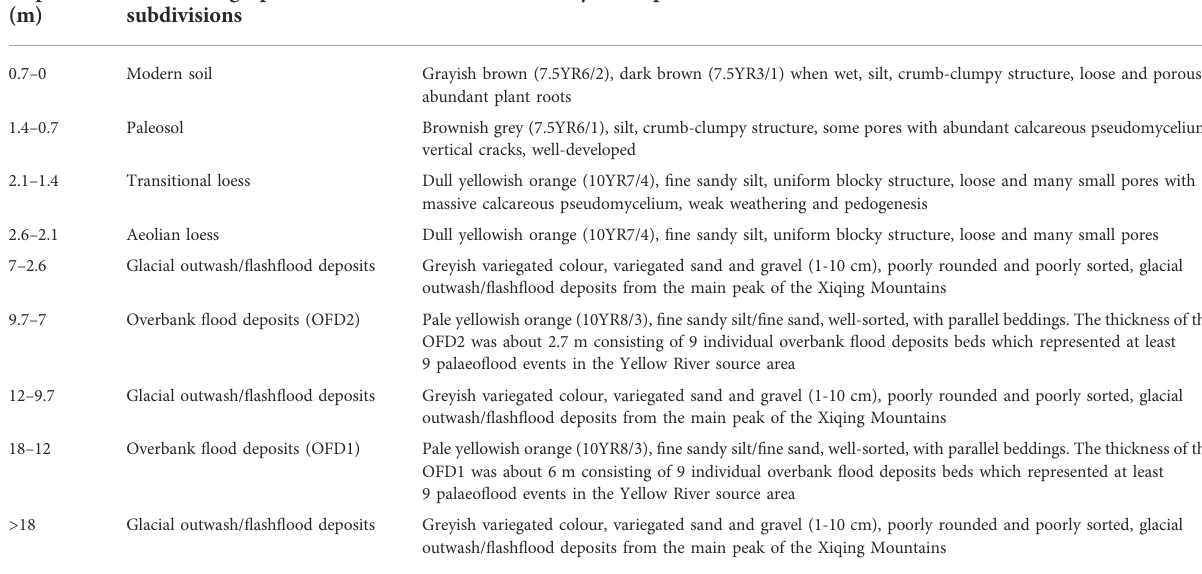
TABLE 1 Pedo-stratigraphic subdivisions and descriptions of the CMQ pro fi le in the Yellow River source area on the NE Tibetan Plateau. Depth